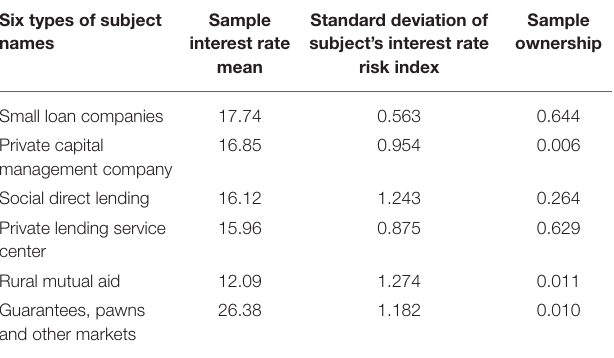
TABLE 2 | Interest rates and risks of different lending topics.